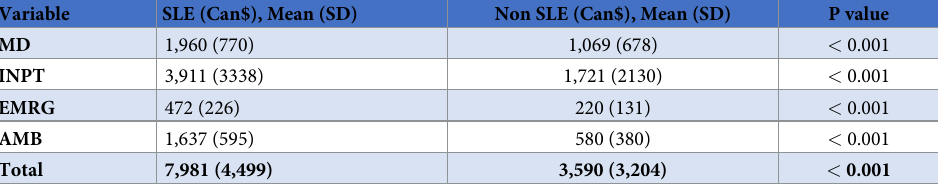
Table 2. Mean costs for SLE and Non SLE per